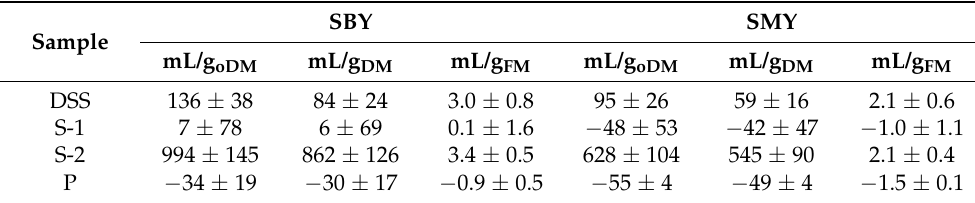
Table 6. Substrate specific biogas yield (SBY) and specific methane yield (SMY) based on fresh matter (FM), dry matter (DM) and organic dry matter (oDM) for digested sewage sludge (DSS), spruce-based (S-1, S-2) and poplar-based press waters (P). For S-1 and P, negative values indicate a reduction of the gas yield compared to the blank (Figure 3). Mean values ± standard deviation (n = 3). SBY SMY Sample mL/g oDM mL/g DM mL/g FM mL/g oDM mL/g DM mL/g FM DSS 136 ± 38 84 ± 24 3.0 ± 0.8 95 ± 26 59 ± 16 2.1 ± 0.6 S-1 7 ± 78 6 ± 69 0.1 ± 1.6 − 48 ± 53 − 42 ± 47 − 1.0 ± 1.1 S-2 994 ± 145 862 ± 126 3.4 ± 0.5 628 ± 104 545 ± 90 2.1 ± 0.4 P − 34 ± 19 − 30 ± 17 − 0.9 ± 0.5 − 55 ± 4 − 49 ± 4 − 1.5 ±